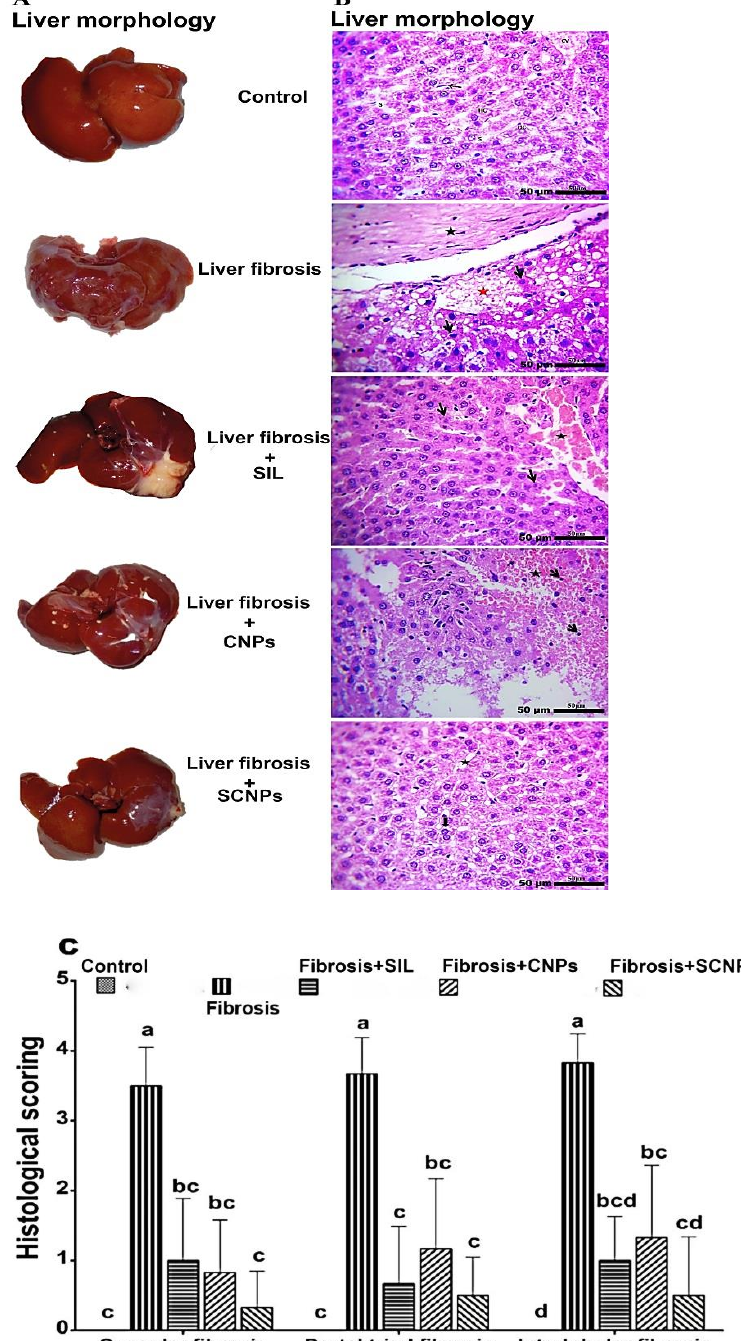
Figure 10. ( A ) Photographs of the liver after tissue was harvested from the animals at the end of the experiment; ( B ) liver sections stained with H&E under the microscope: (Control) showing normal hepatocytes (HC), central vein (CV), sinusoids (S), and kupffer cells (arrow). (Fibrosis) showing mature collagen (star) subscapular necrosis replaced by edema (red star) followed by pyknotic nuclei (arrow). (Fibrosis + SIL) showing mild to moderate pyknotic hepatocytes (arrows) congested and widening sinusoids (star). (Fibrosis + CNPs) showing hepatic necrosis (star) replaced by debris, erythrocytes and a few lymphocytes (arrow). (Fibrosis + SCNPs) showing acute cell swelling of hepatocytes with mild pyknotic in a few hepatocytes (arrow); ( C ) histologic grading of H&E-stained sections for interlobular fibrosis, portal triad fibrosis, and capsular fibrosis, as essential and associated lesions markers for liver fibrosis among treatment groups was performed. Data are presented